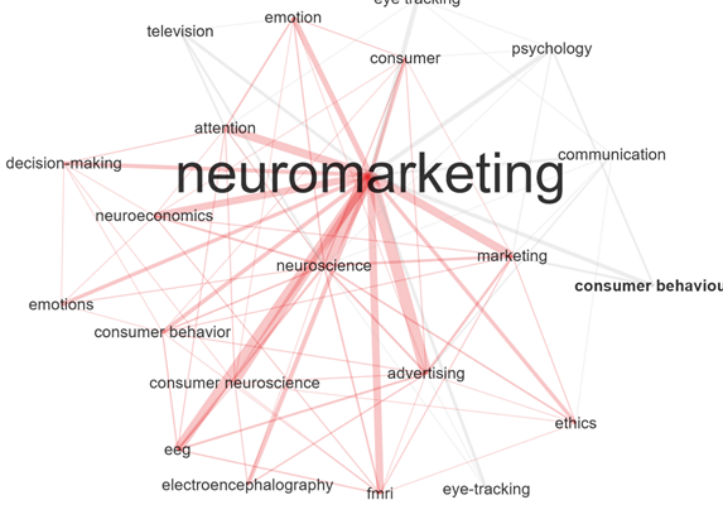
Figure 3. Author keywords: co-word analysis .